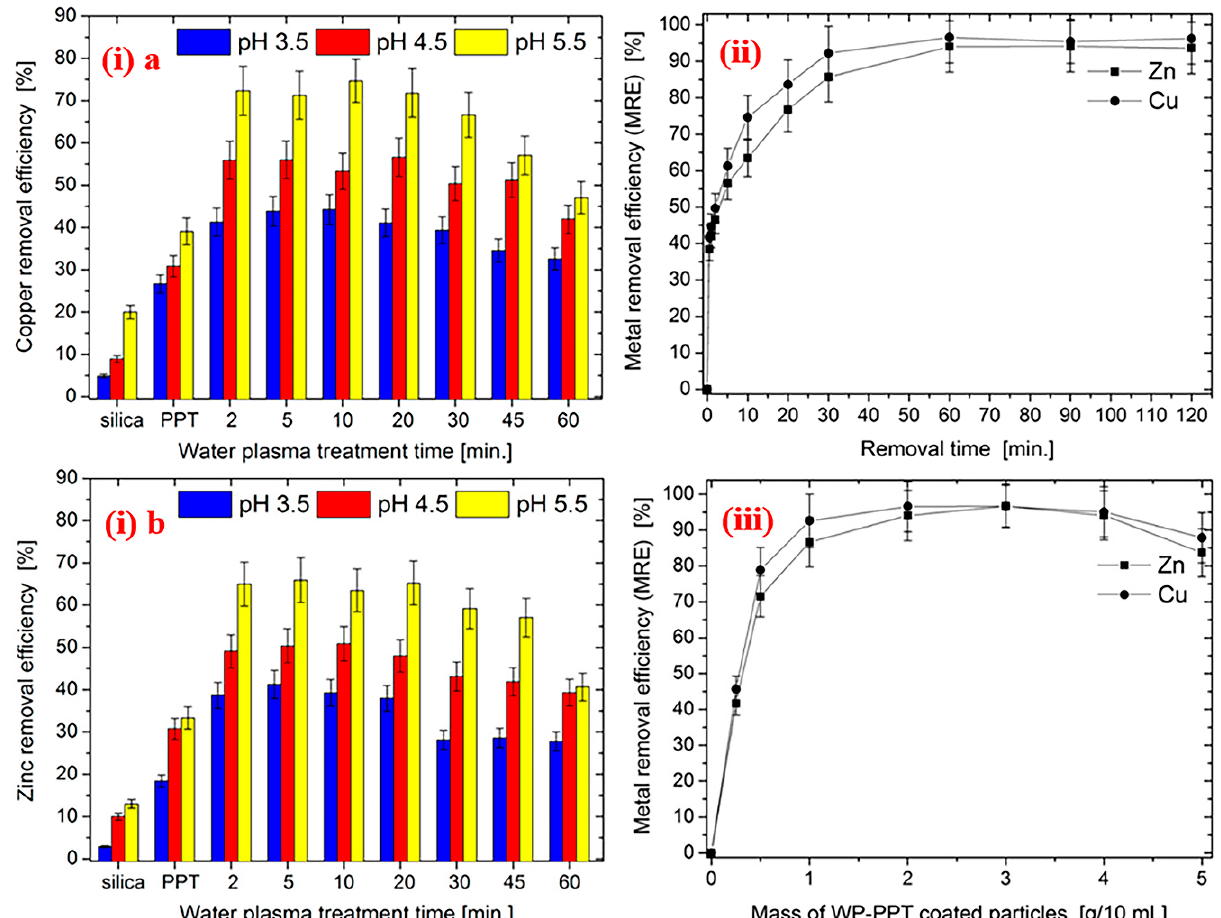
Figure 3. MRE for WP-PPT-coated particles as a function of ( i ) plasma treatment time and pH of solution for ( a ) Cu and ( b ) Zn, ( ii ) time of contact, ( iii ) mass of adsorbent [205], with permission from ACS Publications, 2015.